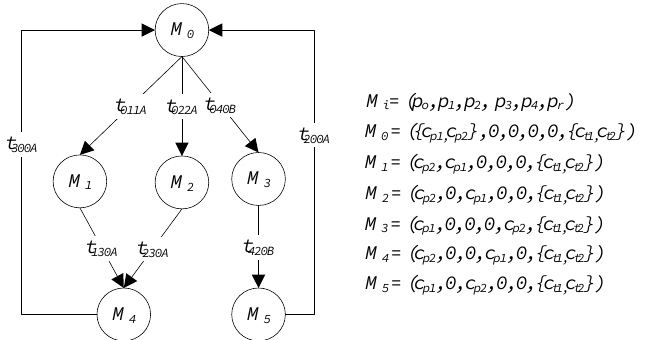
Figure 9. Reachable marking of an ICTPN example, as shown in Figure 2.